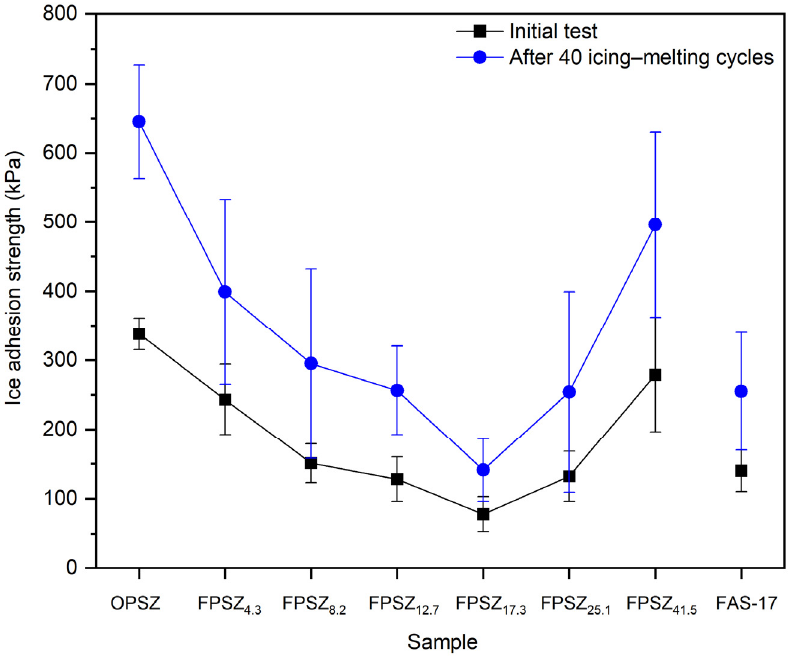
Figure 7. Ice adhesion strengths of the OPSZ-, FPSZ-, and FAS-17-coated rough Al surfaces before and after 40 icing–melting cycles. Table 2. Elemental compositions of the OPSZ-, FAS-17- and FPSZ-coated rough Al substrates. XPS Atomic Concentration